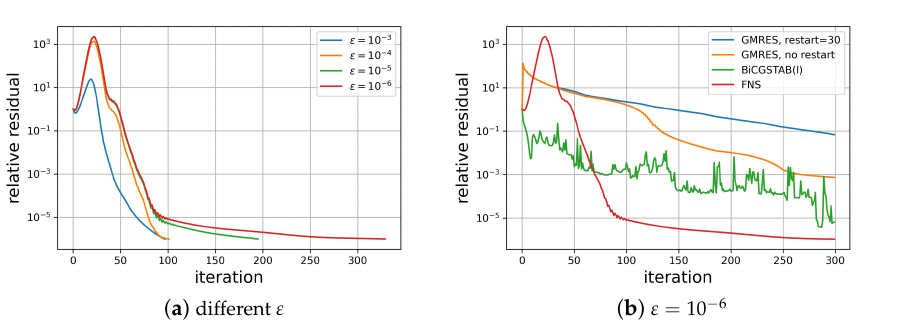
Figure 9. ( a ) Change in relative residual with FNS iteration steps for different ε . ( b ) Comparison of FNS and GMRES, BiCGSTAB( (cid:96) ) when ε = 10 − 6